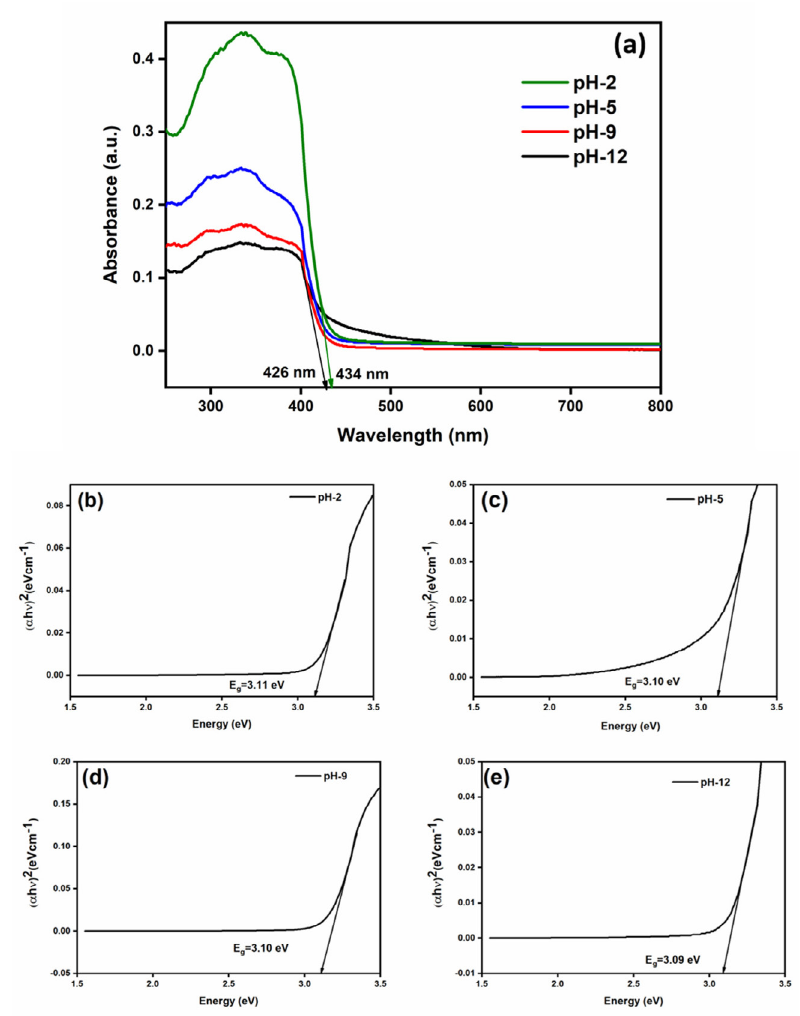
Fig. 6. (a) UV-Vis absorbance spectra of TiO